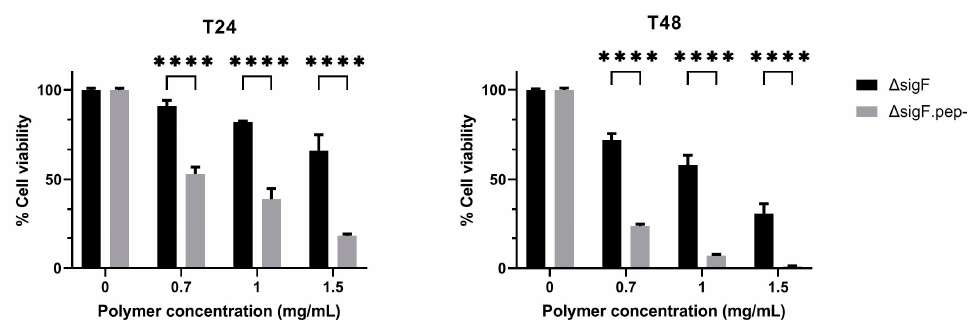
Figure 4. Effect of the Synechocystis Δ sigF polymer ( Δ sigF ) and Δ sigF polymer with reduced peptide content ( Δ sigF .pep-) on the viability of human melanoma (Mewo) cell line, analyzed using PrestoBlue™ viability assay. Cells were treated with 0.7, 1 or 1.5 mg/mL of polymer for 24 or 48 h (T24 and T48, respectively). Cell treatment with polymer vehicle showed no differences compared to Blank (data not shown). Results are express in relation to Blank and are represented as mean ± STD of three independent experiments (**** p ≤ 0.0001).